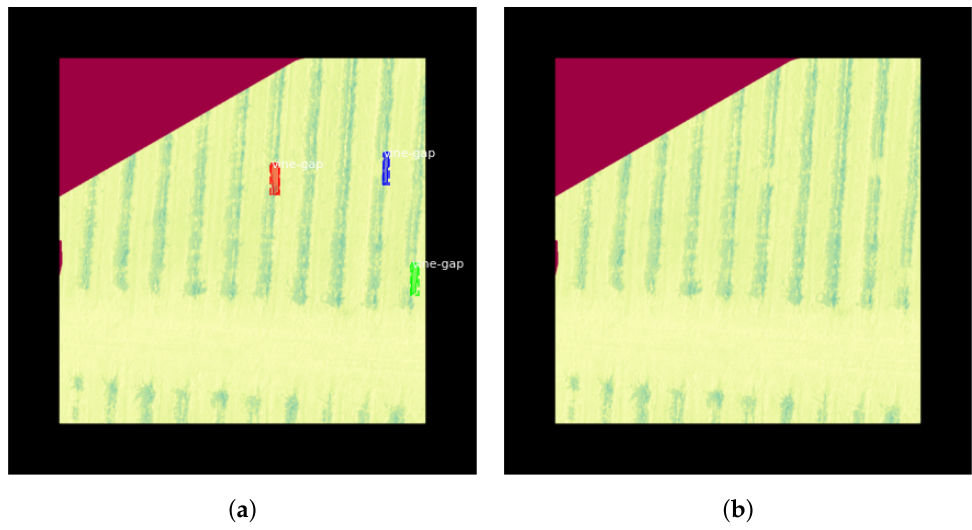
Figure 9. Examples of Mask-RCNN, after training ‘all’ layers for 50 epochs, failing to detect objects. Dataset: NDRE; Weights: YOLO; ( a ): original; ( b ): detected.